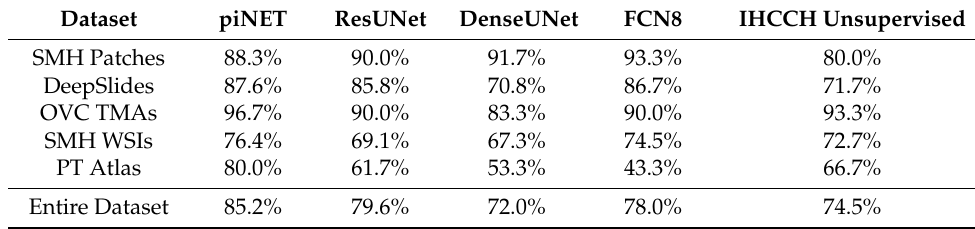
Table 10. PI accuracy rate across all five